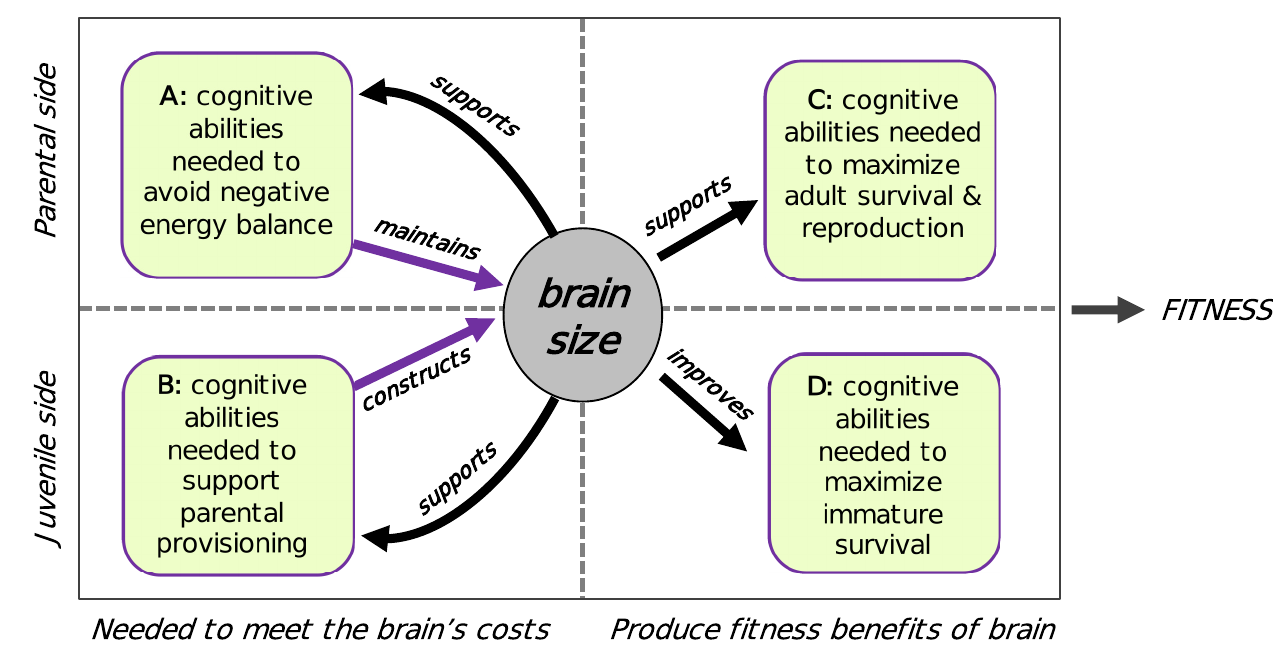
Fig 6. Brain size and the nature of cognition. Natural selection is expected to optimize brain size, by finding the optimum balance between the cognitive abilities (in the broad sense) required to pay for the costs of maintaining the adult brain (A) and constructing it during development (B) on the one hand, and the brain-size-dependent cognitive abilities that are translated into adult performance (C) and immature performance (survival: D) on the other hand. The 4 sets of cognitive abilities no doubt show high overlap, but their nature remains poorly studied. For birds, set A would presumably contain abilities such as migratory habits, food storing, extractive foraging, and communal roosting; set B abilities like predation avoidance (especially of nest contents), efficient foraging, habitat and nest site selection, flexibility, coordination ability; set C many of the same abilities as A and B, but also avoidance of predation on adults, post-independence skill learning, optimal mate choice, and social skills; and set D also nest site selection, nest building, and predation-sensitive